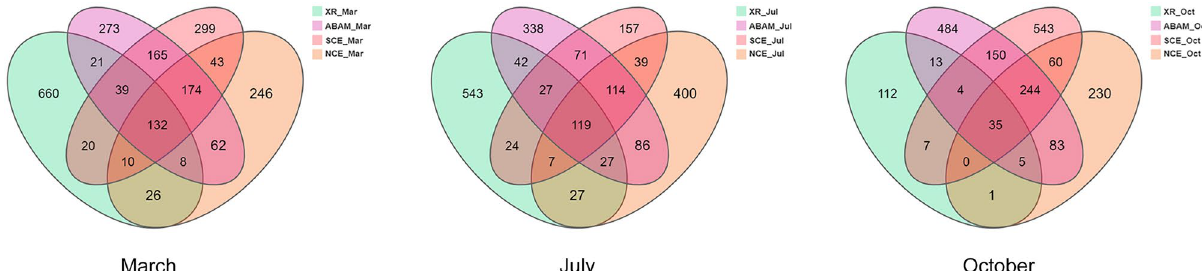
Figure 1. Temporal dynamics of the relative abundances of top bacterial phyla and genera of the three sampling treatments (ABAM, SCE and NCE) Plus the samples from the natural environment (XR) for the three different localities. ( A – C ) Relative abundance of key bacterial Phyla in March, July, and October respectively. ( D ) Relative abundance of key bacterial Phyla of total bacteria grouped for all three localities with the different treatments plus the XR. ( E – G ) Relative abundance of dominant bacterial genera in March, July, and October respectively. ( H ) Relative abundance of key bacterial Genera of total bacteria grouped for all three localities with the different treatments plus the XR ( I ) Heat map of the relative abundance of the 20 most abundant classes over